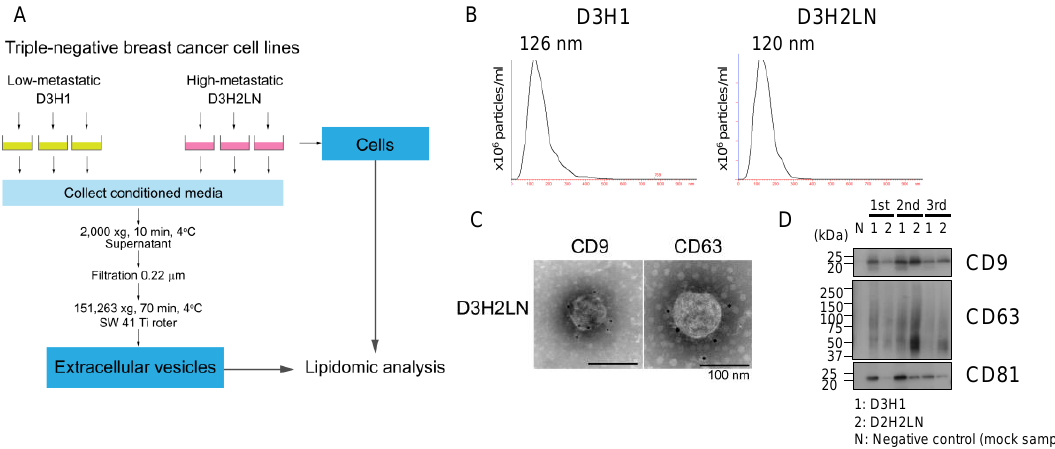
Figure 1. Isolation and characterization of extracellular vesicles (EVs) from high- and low-metastatic breast cancer cell lines. ( A ) Schematic representation of sample preparation. EVs were isolated from conditioned media of low-metastatic breast cancer cell lines, MDA-MB-231-D3H1 (D3H1), and high-metastatic MDA-MB-231-D3H2LN (D3H2LN) by ultracentrifugation with 3 independent replicates. The exact same cells were used for lipidomic analyses. ( B ) Particle distributions of D3H1 and D3H2LN EVs by nanosight particle tracking system. ( C ) Immuno-electron microscopy images of EVs isolated from D3H2LN. CD9 and CD63 at the surface of EVs from D3H2LN were detected by antibodies conjugated with gold nanoparticles. Scale bar: 100 nm. ( D ) Immunoblot of EV marker genes in D3H1 and D3H2LN EVs. Negative control (mock sample) was prepared through the same EV isolation procedure from cell-free control medium.